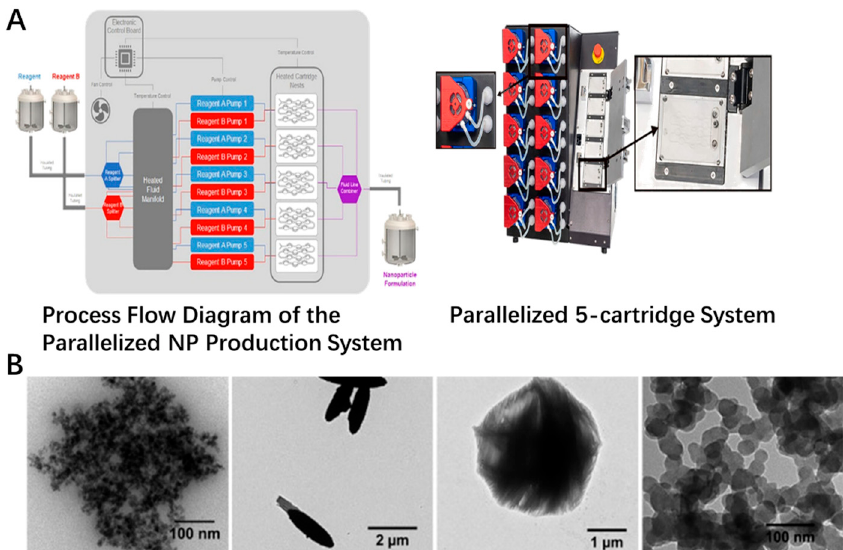
Figure 1. Scale-up platform currently in development and inorganic particle species formed on-chip. ( A ) Flow schematic of high-throughput assembly. The structure of microfluid platform with insets of disposable positive displacement pumps and cartridge holder that does not require manual fluidic connections. ( B ) TEM images of ZnO particles prepared by using LGD variant at FRR of 1:1, 1:6, and 1:20. Iron oxide particles fabricated at a TFR of 10.5 mL/min and FRR of 1:2.